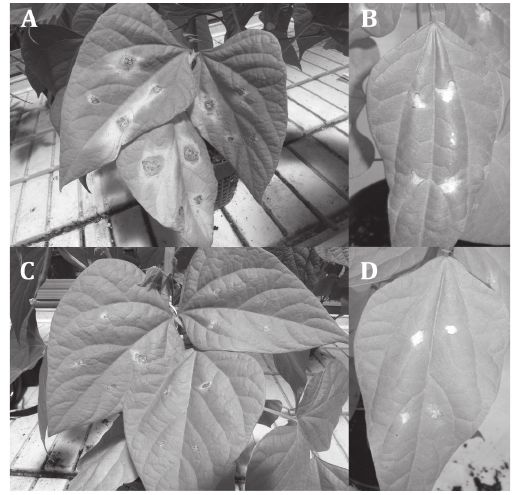
Figure 1. Symptoms on the traditional cultivar Verdolino (A–C) of Fagioli di Sarconi and hypersensitive necrotic lesions on the CBB resistant breeding-line ABC-Wiehing (B–D) 21 days after inoculation with strain USB749 of Xanthomonas axonopodis pv. phaseoli var. fuscans (A–B) and strain USB771 of X. a. pv. phaseoli